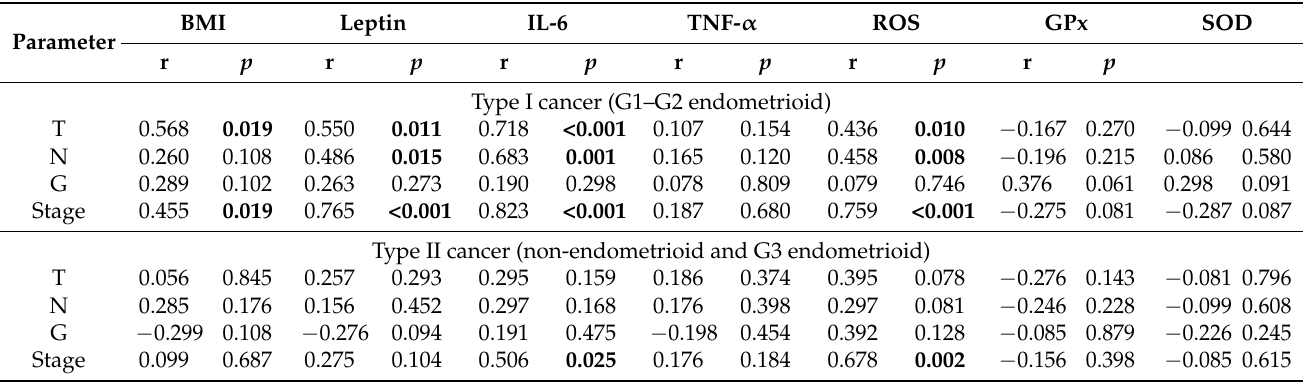
Table 7. Correlation between BMI, leptin, proinflammatory cytokines, and oxidative stress parameters within tumor prognostic characteristics.